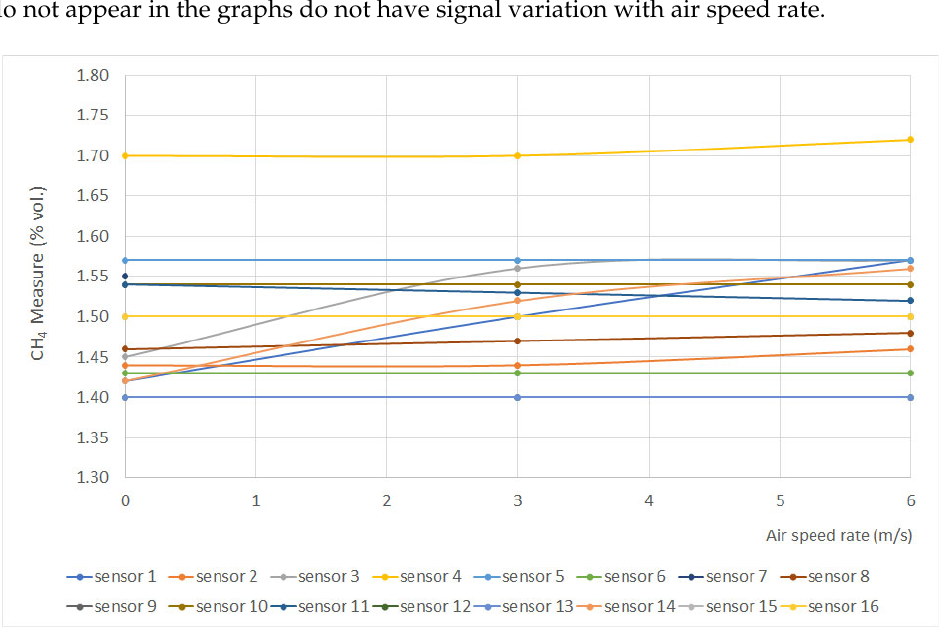
Table 7. Residual effect results.